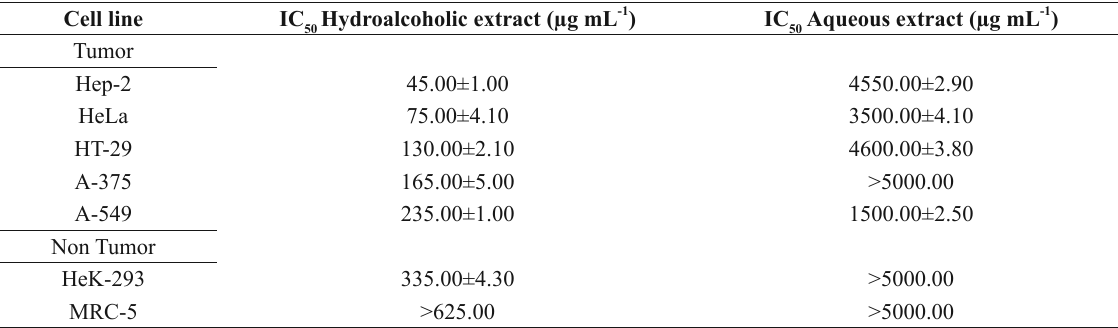
values – 50% inhibitory concentration obtained in the MTT assay for tumor and non-tumor cell after S. IC 50 of fi cinalis exposure 24h